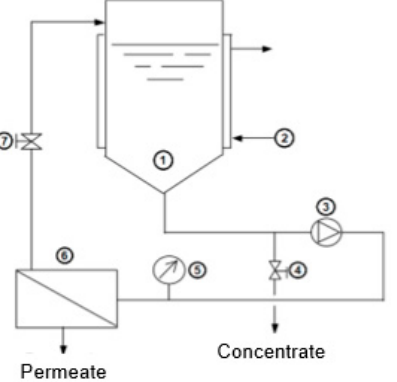
Figure 2. Schematic representation of the Celfa-P28 UF experimental set-up: (1) feed tank; (2) heating/cooling jacket; (3) pump; (4) valve of concentrate collector; (5) manometer; (6) permeate cell; (7) pressure retention valve.